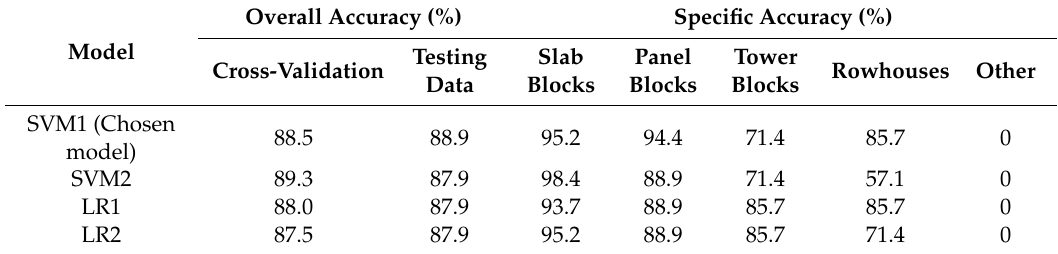
Table 7. Details for four of the considered models for prediction of building type.